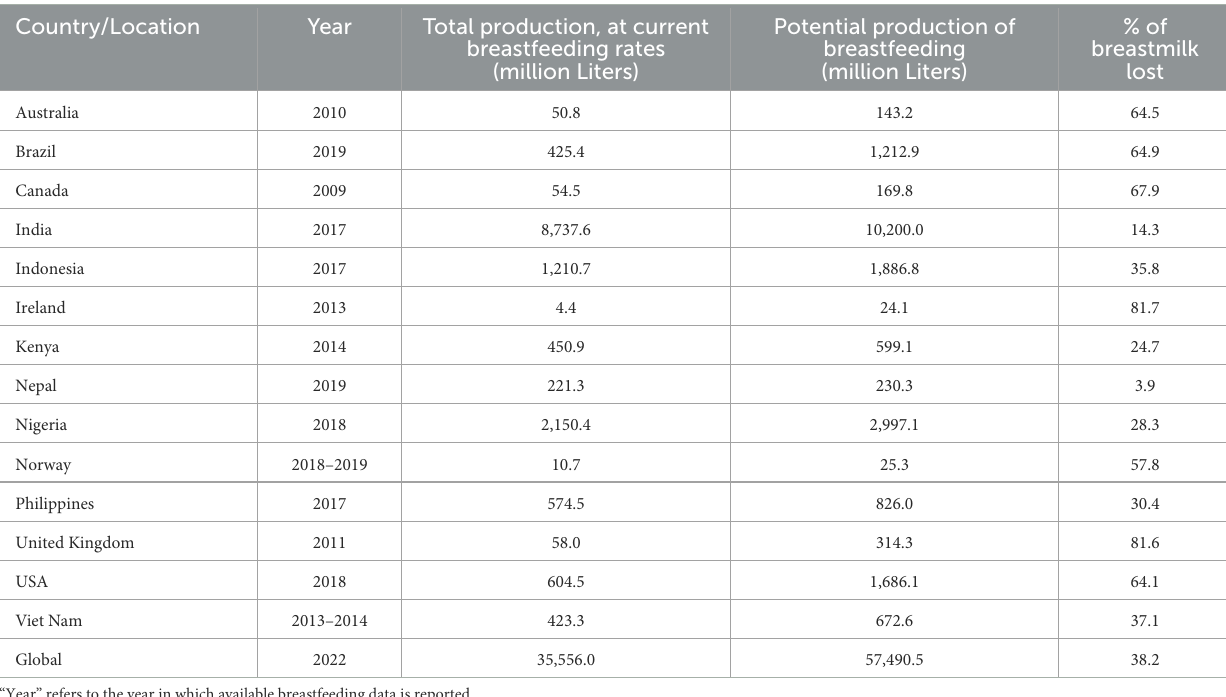
TABLE 4 Estimated amounts and values of actual and potential human milk production by country for children aged 0–36 months.